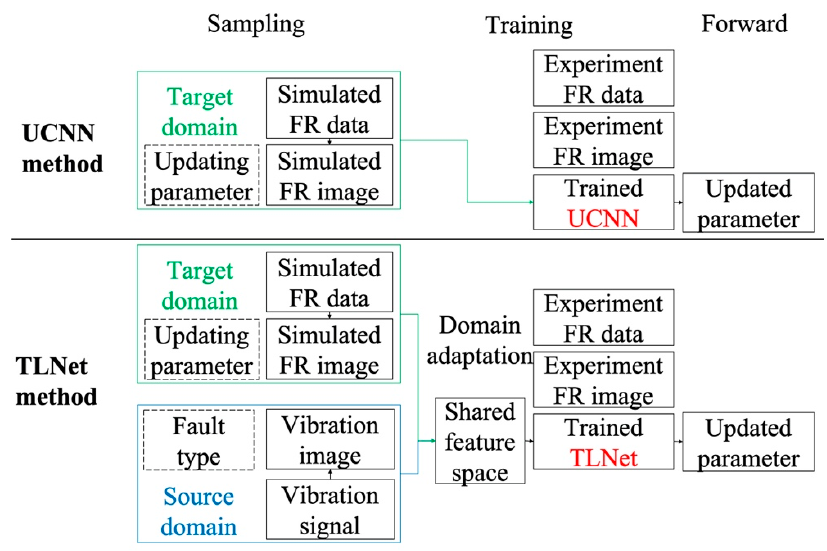
Figure 2. Flowchart of the UCNN [8] method and TLNet method.